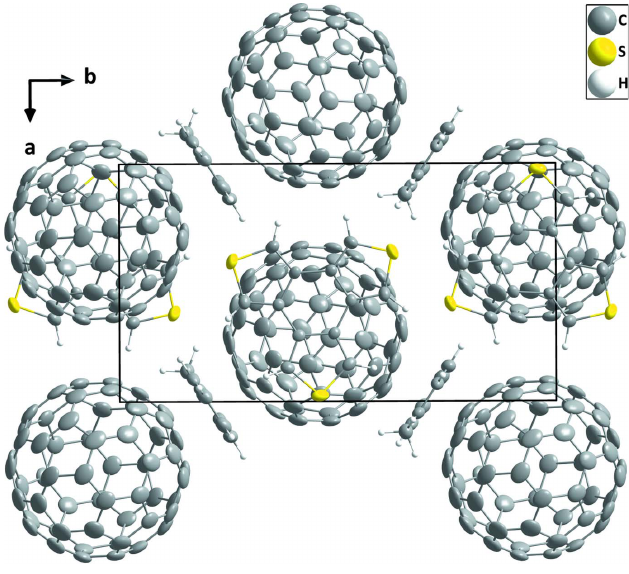
Figure 5 Packing of BTT- D 3h (cid:2) C 60 (cid:2) toluene viewed along the c -axis direction. Minor disordered atoms are omitted for